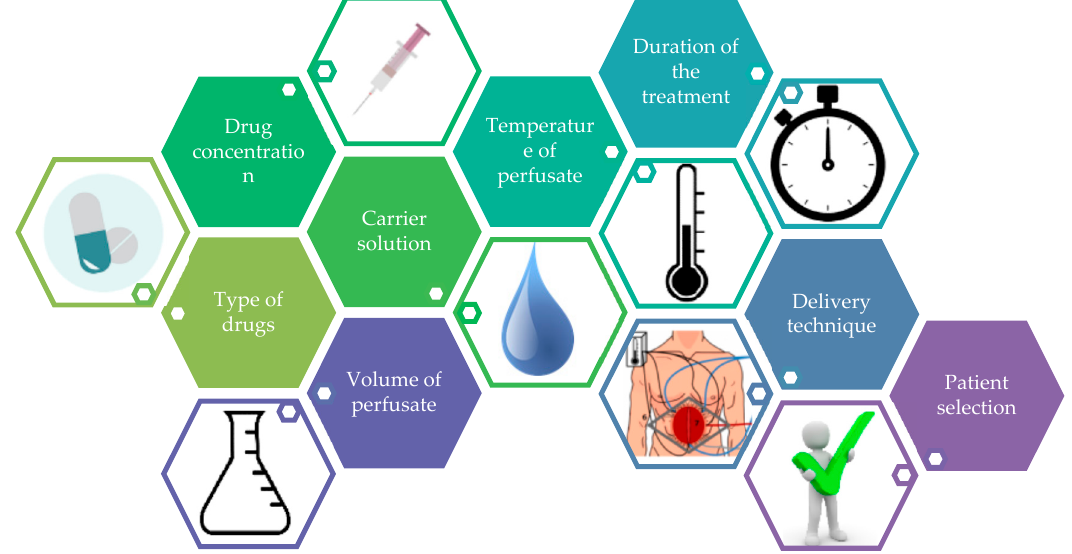
Figure 2. Eight parameters of hyperthermic intraperitoneal chemotherapy (HIPEC).